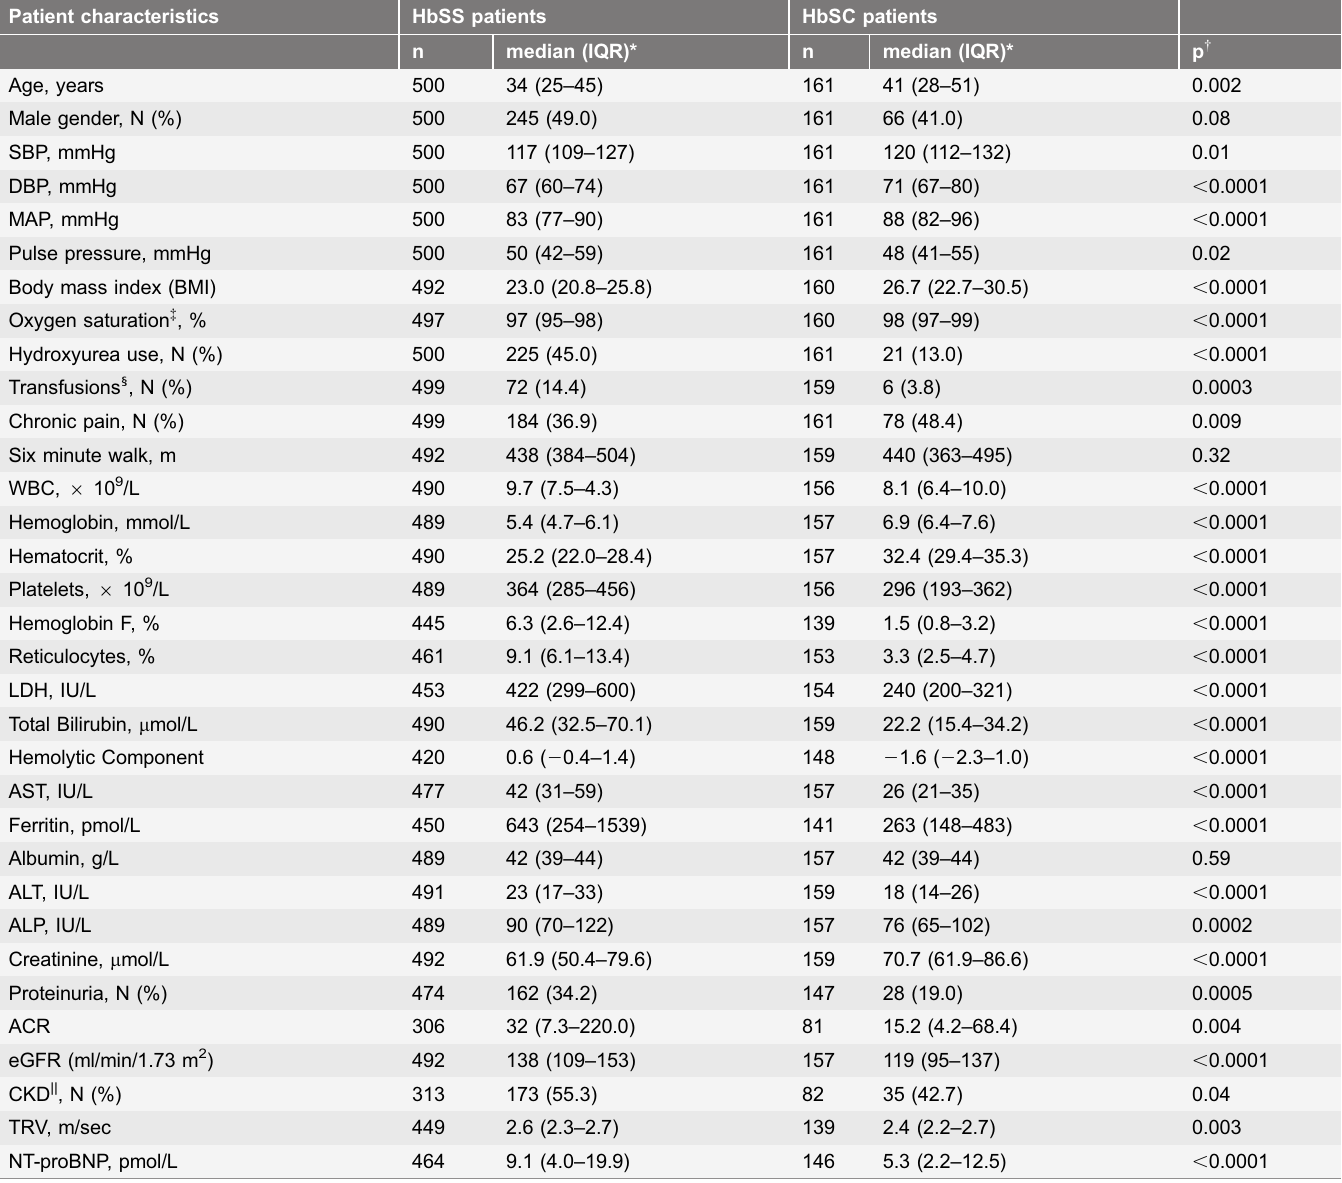
Table 1. Patient characteristics by sickle cell disease